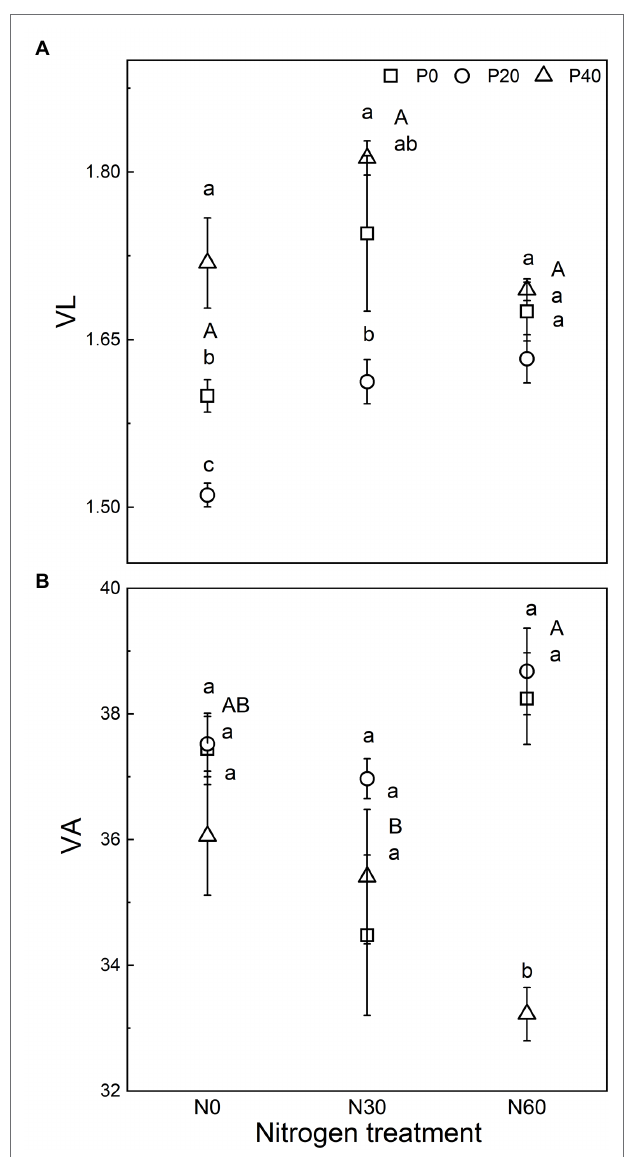
FIGURE 4 | Vector analysis of enzyme activity to indicate the effect of nitrogen (N) deposition and phosphorus (P) addition on the relative nutrient limitation of the soil. (A) Vector length indicates soil C limitation. (B) Vector angle indicates the relative nutrient limitation of N or P. VL, vector length; VA,